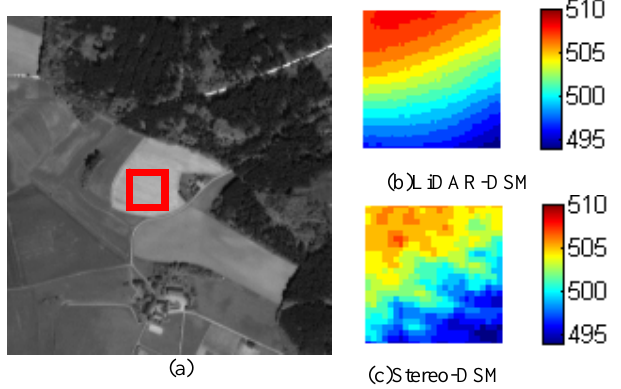
(b)LiDAR-DSM Figure 3. DSM quality analyses ((a) The flat area chosen for analysis; (b) the height distribution from LiDAR data; (c) the height distribution from DSM generated for year-2008 Four groups of pixels are chose and compared in this test. As shown in Figure 4, the blue circles in the blue line stands for the height value from the stereo-DSM, while the red crosses in the red line are